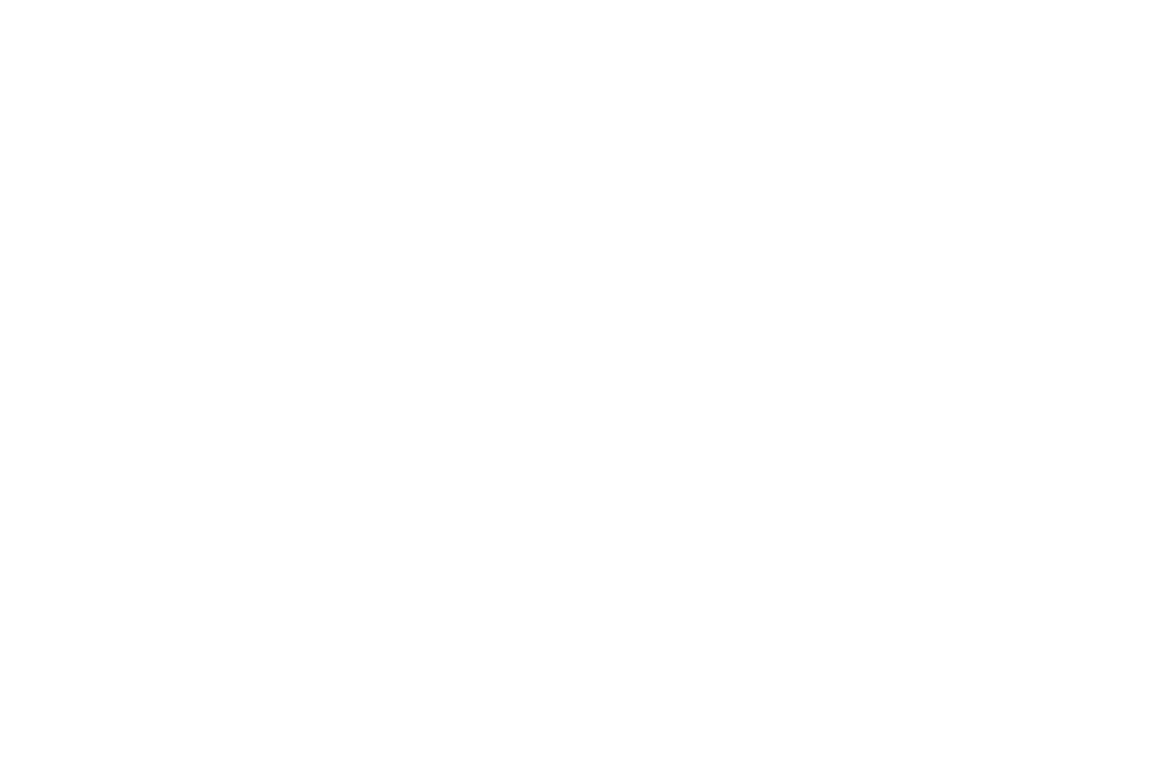
Frontiers in Robotics and AI |